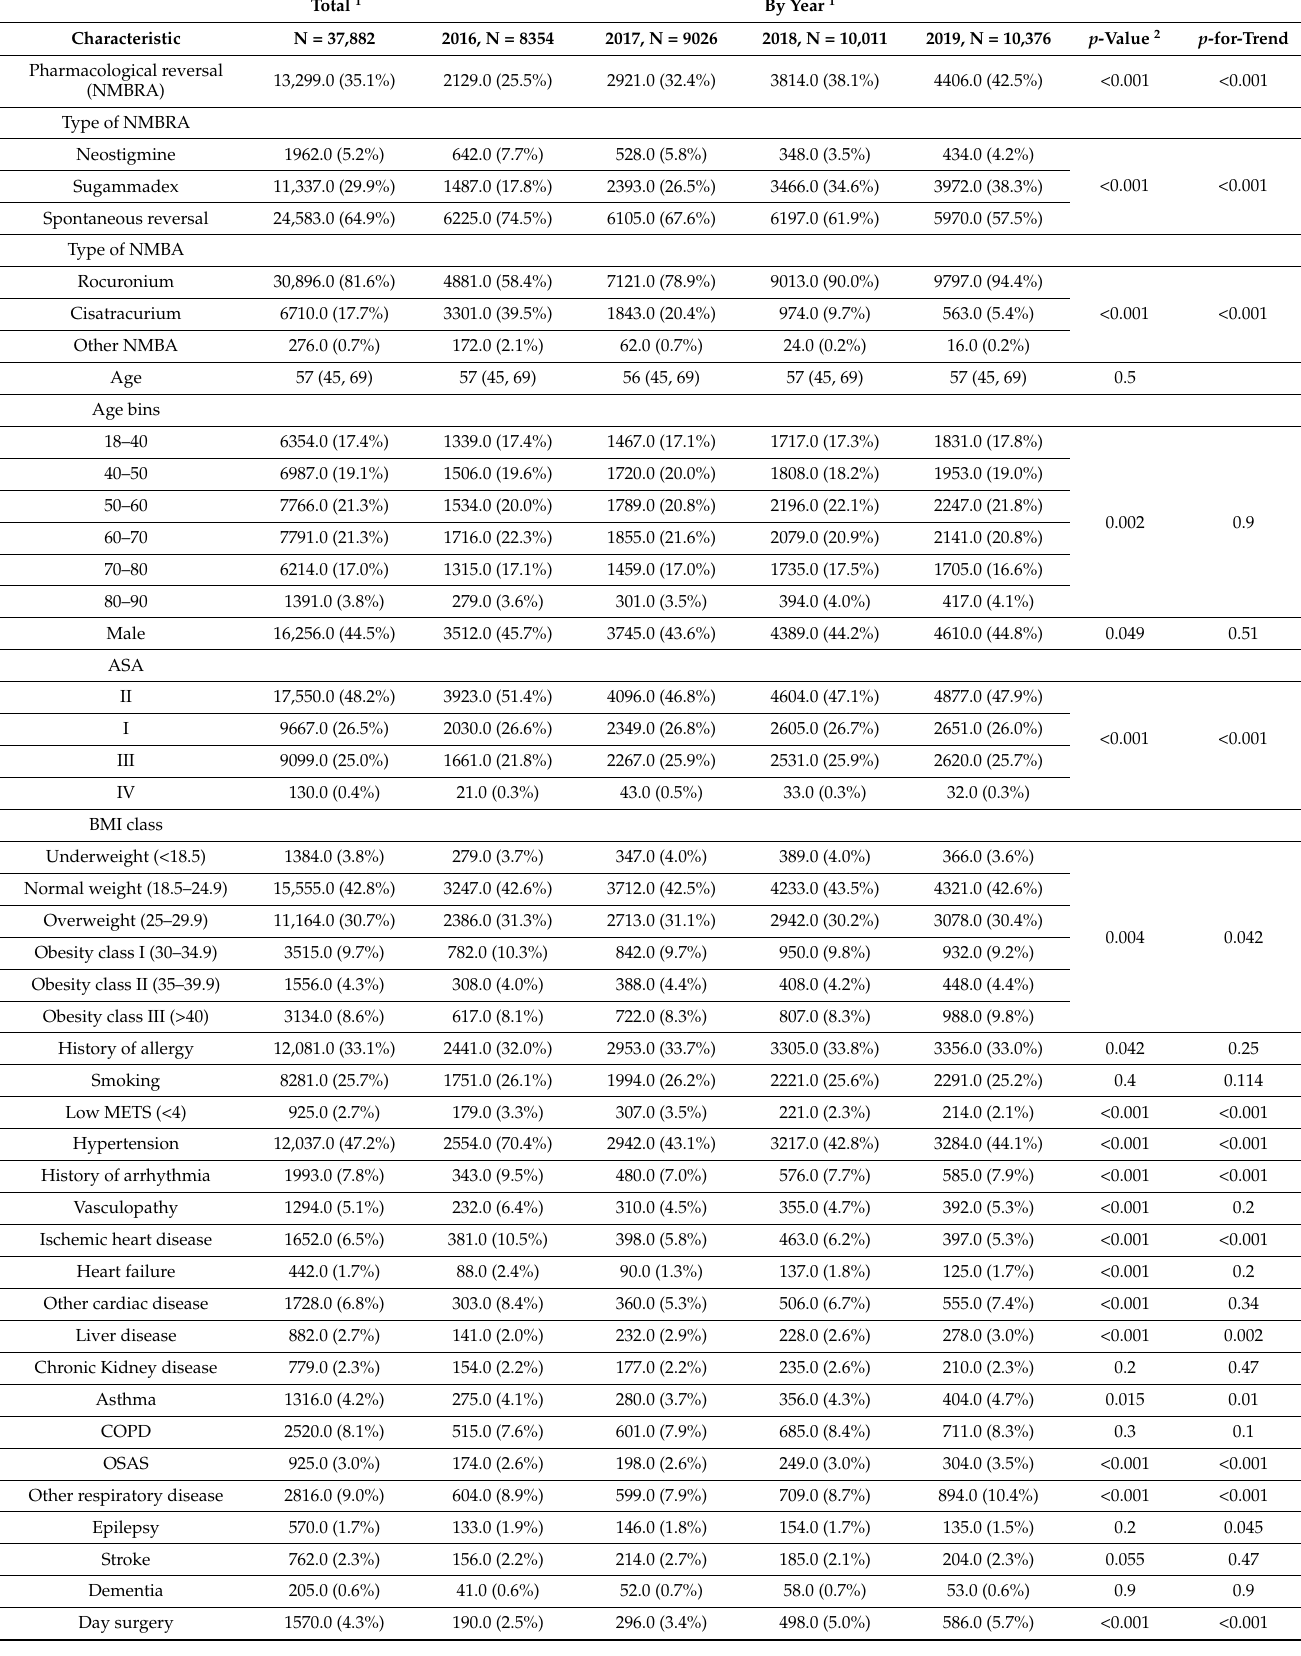
Table 2. Time trends of NMBA reversal, NMBA use, and patient and surgical characteristics over 4